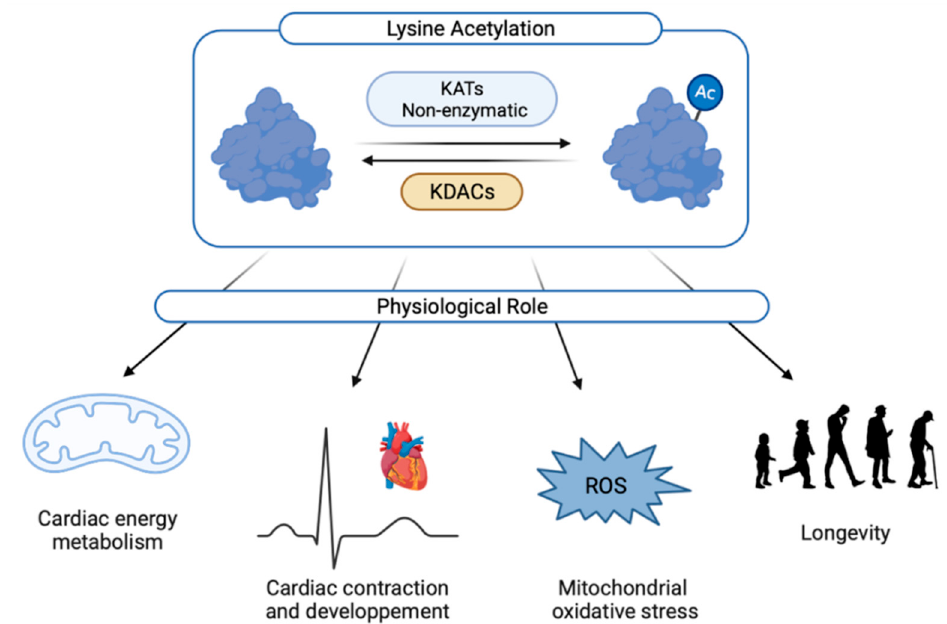
Figure 2. Physiological roles of cardiac acetylation. Ac: acetylated form; KATs: lysine acetyltrans- ferases; KDACs: lysine deacetylase; ROS: reactive oxygen species. ferases; KDACs: lysine deacetylase; ROS: reactive oxygen